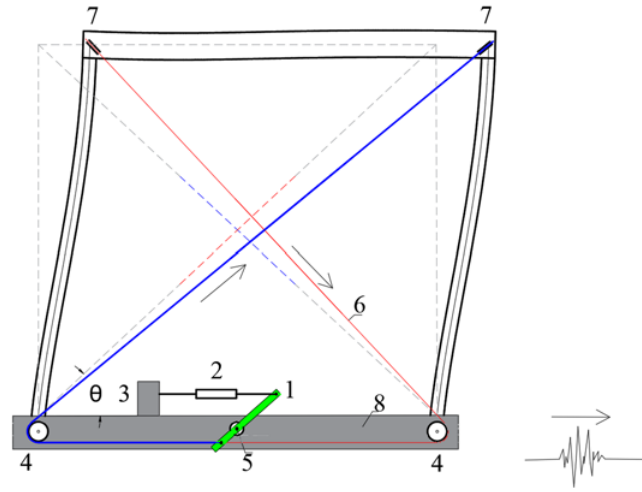
Figure 1. Conceptual model of simple 1-floor frame structure equipped with proposed system: 1 lever arm; 2 viscous damper (VD); 3 contrast; 4 pulleys; 5 pin; 6 wire; 7 clamp; 8 foundation.